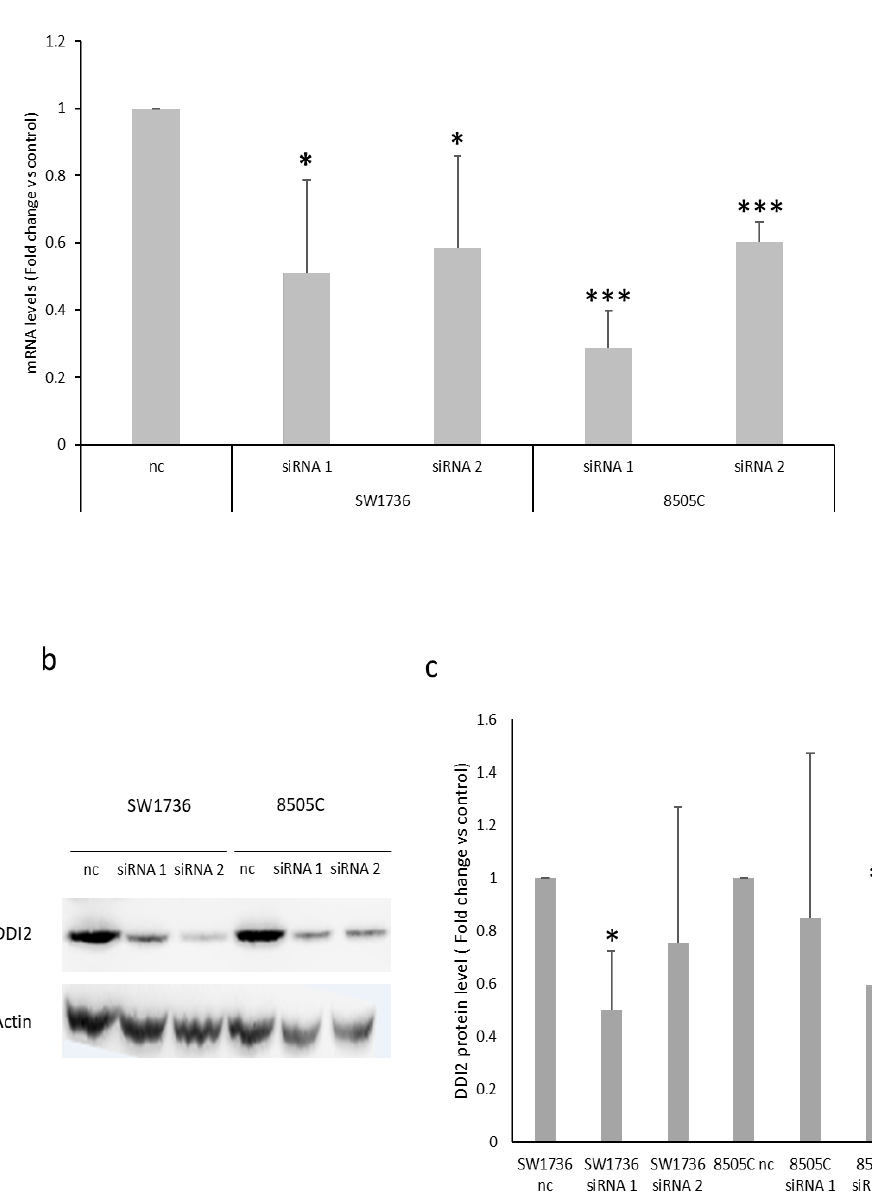
Figure 6. Investigation of targets commonly down-regulated after METTL3 silencing in ATC cells. ( a ) mRNA levels for DDI2 in ATC cell lines treated with negative control (nc) or METTL3 -specific siRNAs (siRNA 1 or siRNA 2) for 72h. Nc was set to 1 and protein levels were expressed as fold change versus control. n = 3. * p < 0.05, *** p < 0.001. ( b ) Blot image of SW1736 and 8505C cells after 72 h transfection with non-targeting siRNA (nc, negative control) or two different siRNAs (siRNA 1 and siRNA 2) specific to METTL3 . ( c ) Densitometric analysis of DDI2 protein levels in ATC cells treated with negative control (nc) or two different siRNAs (siRNA 1 and siRNA 2) specific to METTL3 . Data are normalized against β -actin levels. Nc was set to 1 and protein levels were expressed as fold change versus control. n = 5. * p < 0.05.